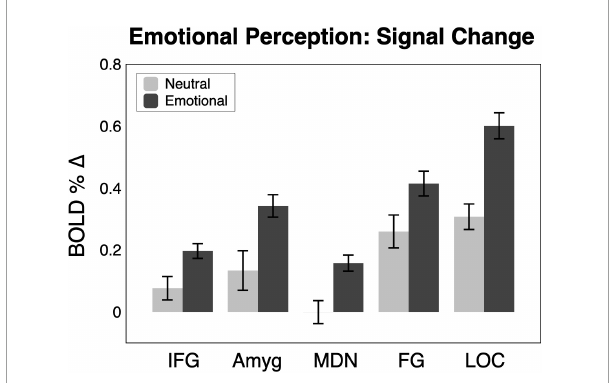
FIGURE3 BOLD signal change across the sample ( n = 23) in the five regions of interest for neutral and emotional scenes. Amyg, amygdala; FG, fusiform gyrus; IFG, inferior frontal gyrus/anterior insula; MDN, medial dorsal nucleus of the thalamus; LOC, lateral occipital